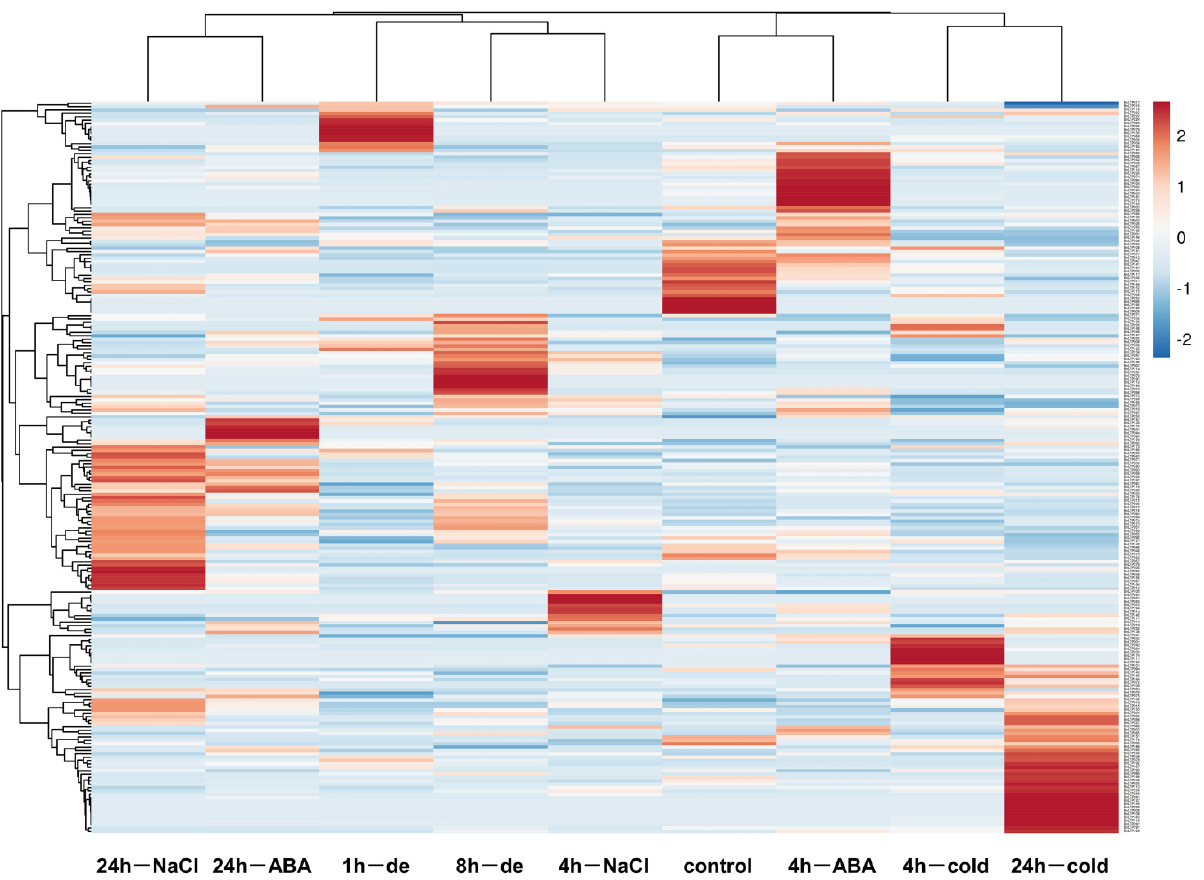
Figure 7. The heatmap of the expression levels of BnLTP family genes in 3 week-old plants of rapeseed under multiple abiotic stresses (NGDC project ID CRA001775), including dehydration (1 h and 8 h), ABA (25 μ M; 4 h and 24 h), NaCl (200 mM; 4 h and 24 h), and cold (4 °C, 4 h and 24 h).